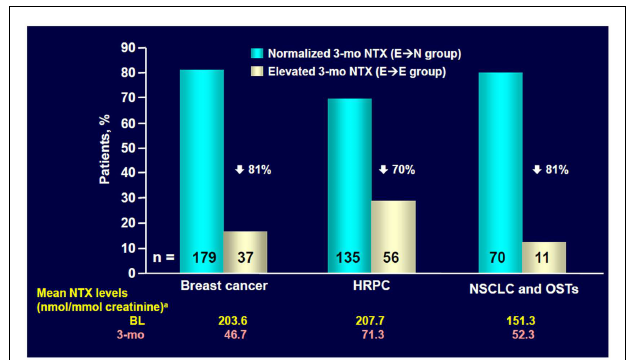
FIGURE 2 | ZOL normalized NTX levels within 3months in most patients with elevated baseline NTX . NTX, N-telopeptide of type I collagen; HRPC, hormone-refractory prostate cancer; NSCLC, non-small cell lung cancer; OST, other solid tumors; BL, baseline. Data from Lipton et al.